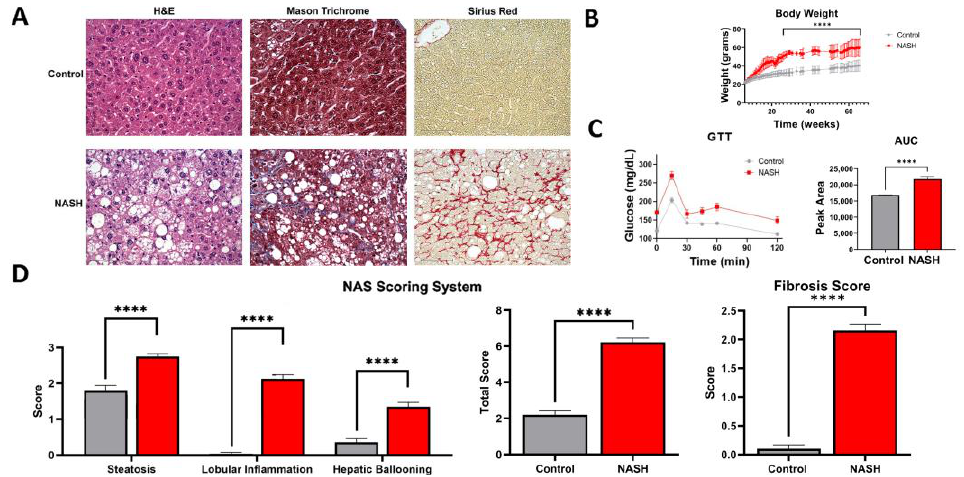
Figure 2. Modified amylin diet induces NASH in mice. ( A ) H&E, Masson trichrome, and Sirius red liver histology staining. Scale bar = 75 µm. ( B ) Body weight of mice. ( C ) Results from glucose tolerance test and area under the curve quantitation. ( D ) The NAS scoring system was used to assess liver histology. Mice fed a modified amylin diet were diagnosed with NASH with a total average NAS score of 6 and fibrosis score of 2. Data presented as mean ± SEM. (N = 7, **** p < 0.0001).